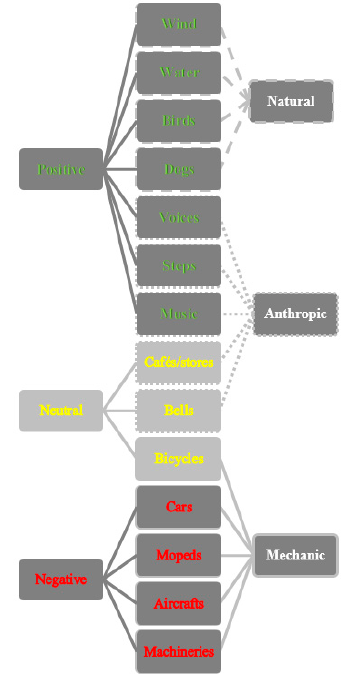
Figure 2. Sound elements and judgments.